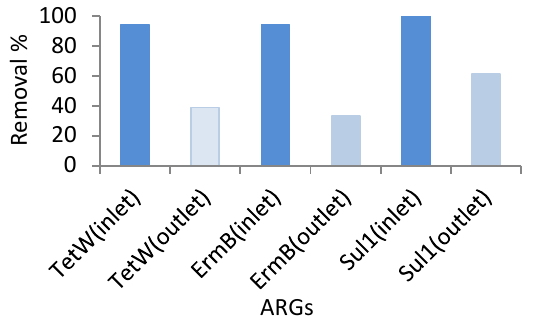
Figure 3. Antibiotic resistance genes (ARGs) detected in influent and effluent of wastewater treatment plants (WWTPs) However, there was a variation in the prevalence of different ARGs. This variation